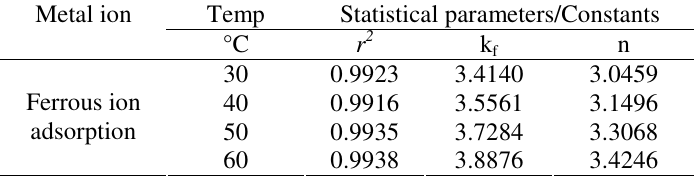
Figure 4. Linear Freundlich isotherm for the adsorption of ferrous ion onto ZDC Table 5. Freundlich isotherm